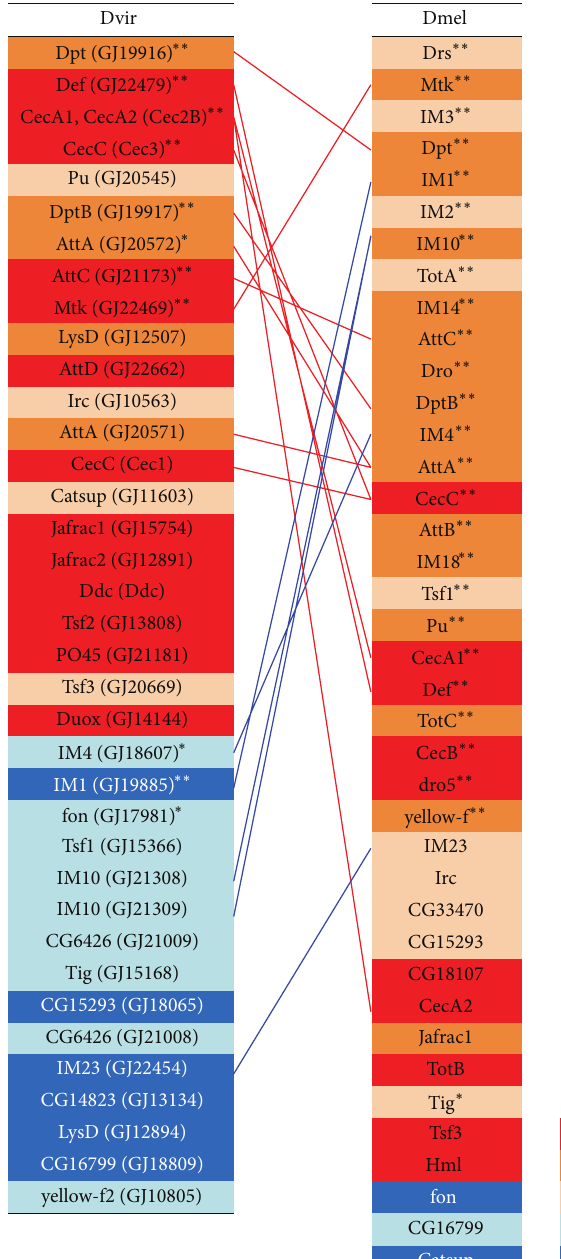
Figure 3: Summary of changes in gene expression level of the effector genes in the Penicillium -infected larvae. The effector class genes are piledintheorderoftheexpressionlevelintermsoftrimmedmeanof 𝑀 values(TMM).Expressionsofgenesobservedonlyinthe Penicillium - infected larvae are displayed in red. Genes of the induction coefficient greater than 2.0, between 1.0, and 2.0, between 0.5 and 1.0 below 0.5 are displayed in dark orange, light orange, light blue, and dark blue, respectively. The AMP genes and the IM genes homologous between D. virilis and D. melanogaster are connected to each other by red lines and blue lines, respectively. For each D. virilis gene, the gene name of its homologue in D. melanogaster is described and the gene name of D. virilis is described in parenthesis. Asterisks indicate a statistically significant difference in the number of reads observed between the infected and na¨ıve larvae ( ∗ 𝑃 < 0.05 ; ∗∗ 𝑃 < 0.01 ).